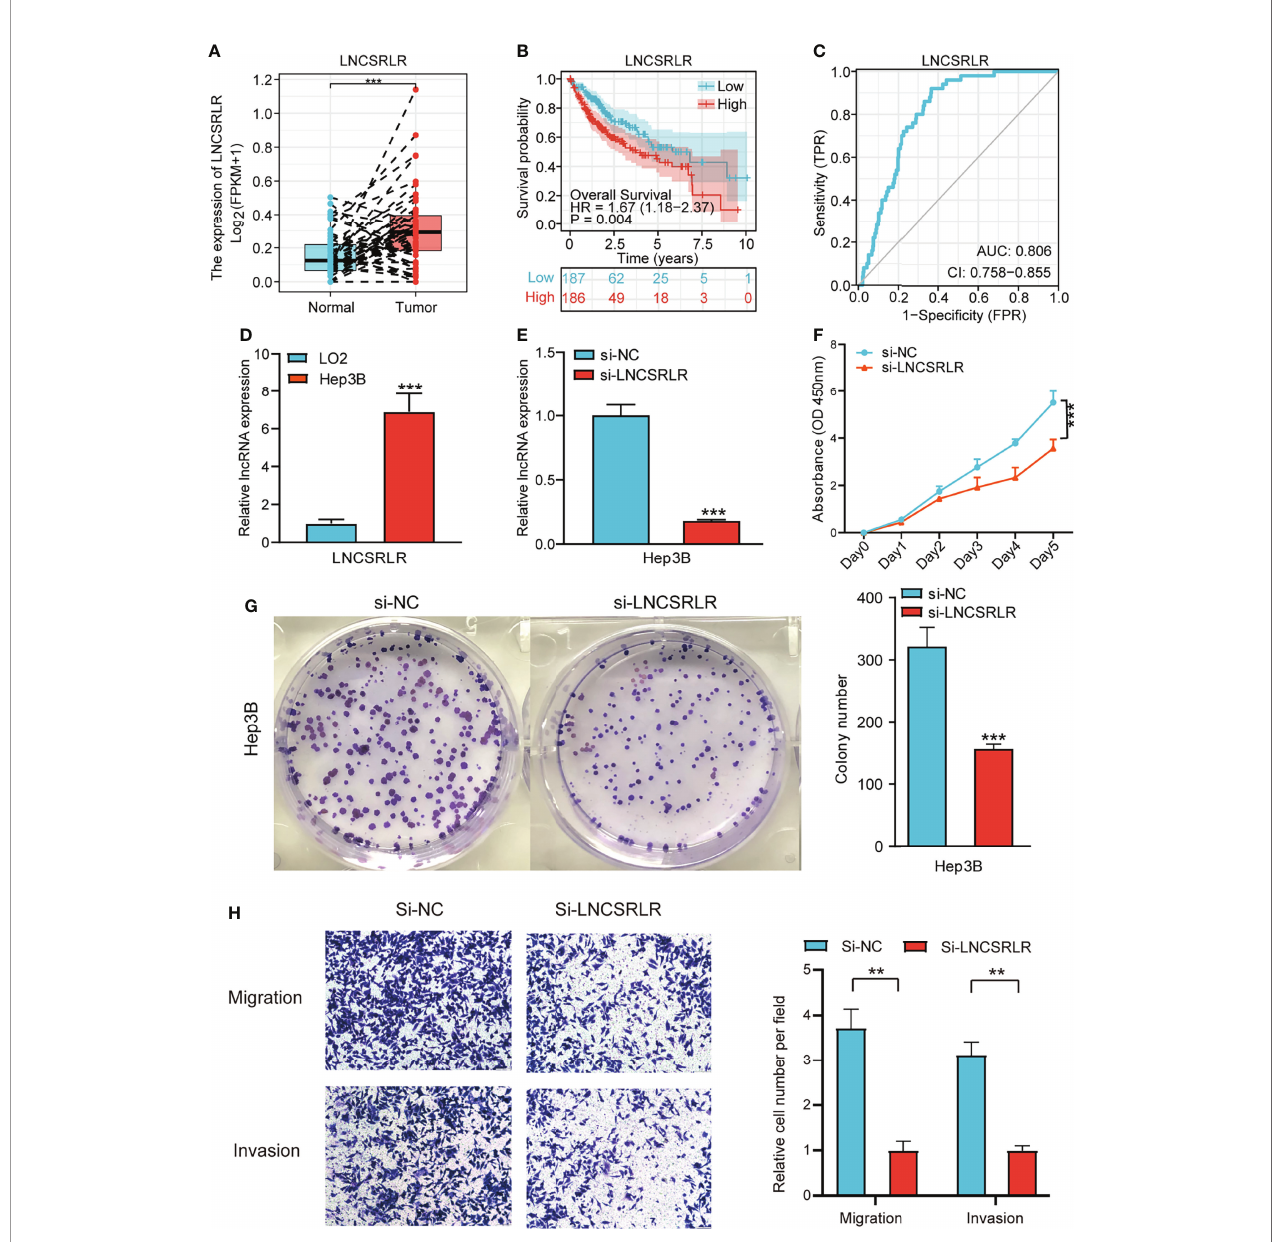
FIGURE 10 | The role of LNCSRLR in HCC. (A) Differential expression analysis of LNCSRLR in paired samples of TCGA HCC cohort. (B) Kaplan – Meier analytical evaluation of the prognostic values of LNCSRLR. (C) ROC curve of LNCSRLR for assessing the diagnostic performance in HCC. (D) RT-qPCR result of LNCSRLR in normal human hepatic cell line (LO2) and HCC cell line (Hep3B). (E) RT-qPCR validation of downregulation by siRNA. (F) CCK-8 cell proliferation curve. (G) Self- renewal ability was detected by plate-cloning experiments. (H) Transwell migration and invasion assays. HCC, hepatocellular carcinoma; TCGA, The Cancer Genome Atlas; ROC, receiver operating